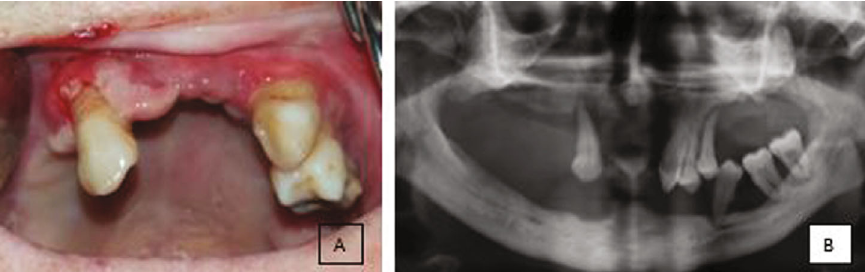
Figure 3: (a) The image showing that the clinical attachment loss was severe in the periodontal tissue. Bleeding, swelling, atrophy, and fl oppy were observed in the gingival tissue. (b) The panoramic radiography image of the patient.